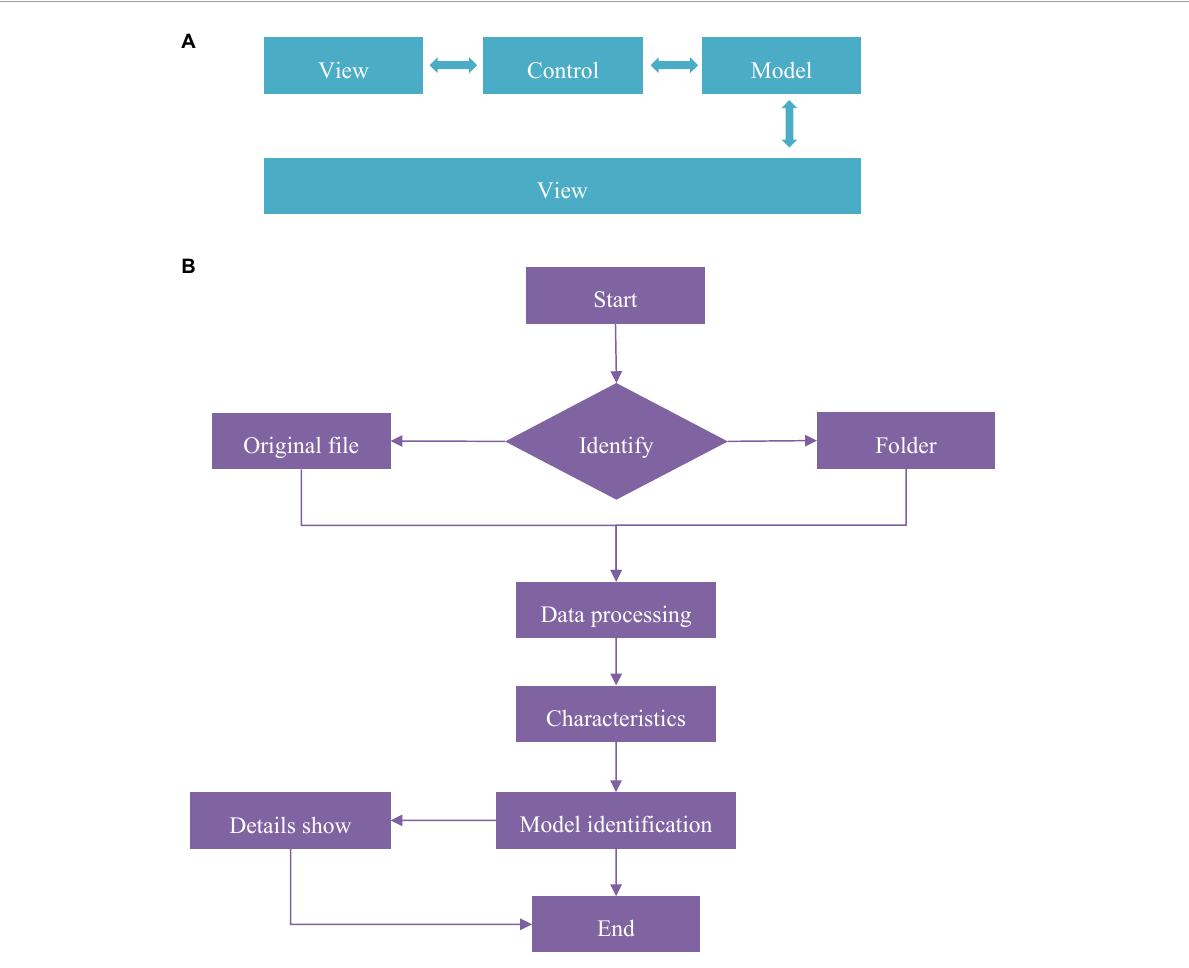
Figure 6 compared the plasma ACTH and COR levels at 8:00, 16:00, and 24:00 of patients in the A-MDD and NA-MDD groups. It was found that COR8 in the A-MDD group